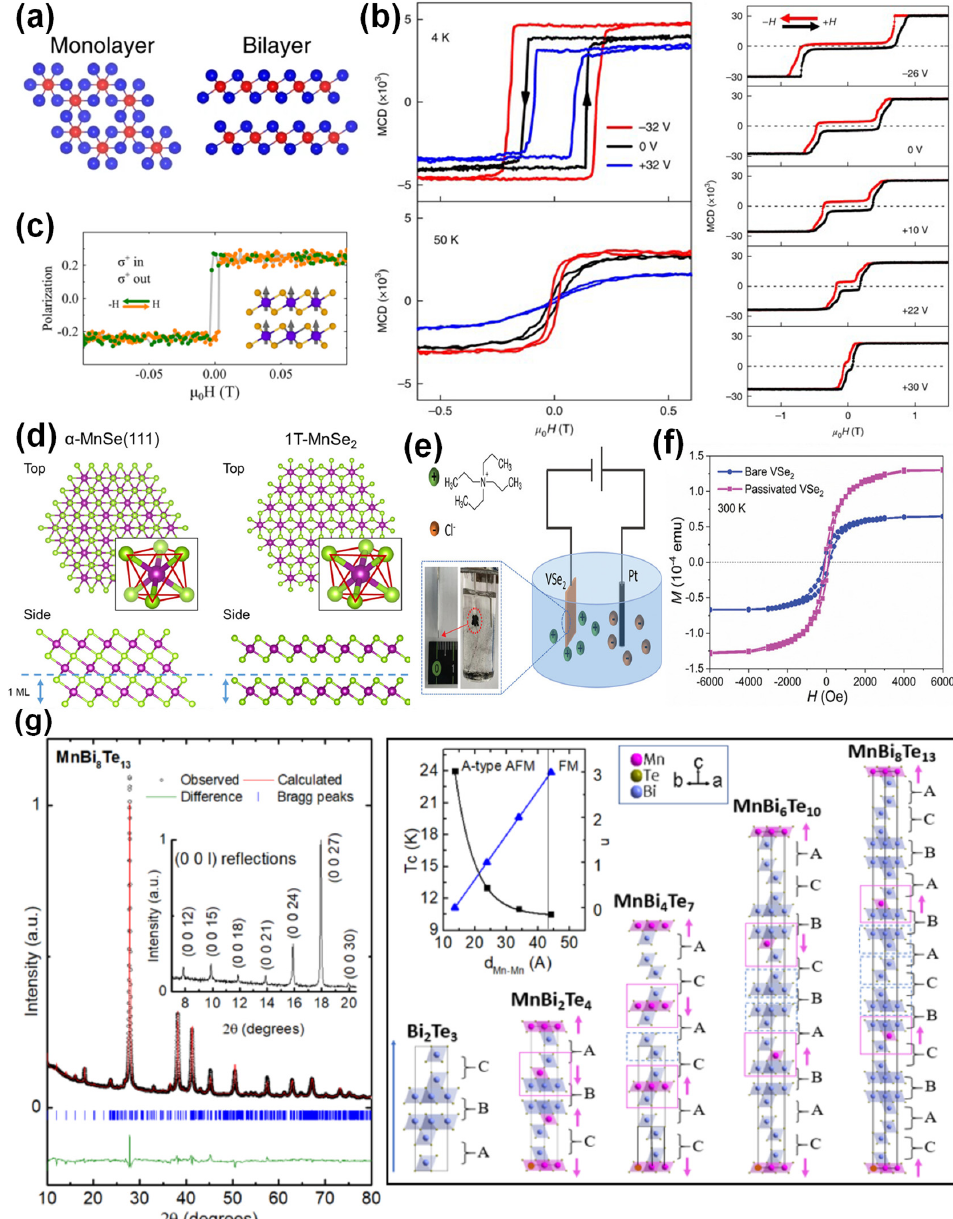
Figure 3. ( a ) Top view of monolayer CrI 3 , where the Cr atoms (red balls) form a honeycomb structure in edge-sharing octahedral coordination by six I atoms (blue balls), and side view of bilayer CrI 3 of the rhombohedral stacking order. Reused with permission from [74] . ( b ) MCD versus magnetic field (left) at three representative doping levels at 4 K (top panel) and 50 K (bottom panel); MCD versus magnetic field at 4 K at representative gate voltages (right). Reused with permission from [75]. ( c ) Hysteresis loop for bilayer CrBr 3 . Reused with permission from [76] . ( d ) Crystal structure diagrams of α -MnSe (111) and monolayer 1T-MnSe 2 . Reused with permission from [80] . ( e ) Schematic illustration of the electrochemical setup for cathode exfoliation of VSe 2 using tetra propylammonium cation (TPA) as the intercalant. Inset: photograph showing a small piece of a VSe 2 crystal clamped by two titanium plates (left), and visible expansion of the VSe 2 cathode with a fluffy shape (right). Reused with permission from [91]. ( f ) M – H hysteresis loop of bare and passivated VSe 2 flakes at 300 K, shown in ( e ). Reused with permission from [91]. ( g ) Structure determination and the stacking rule in MnBi 2 n Te 3 n +1 . Reused with permission from